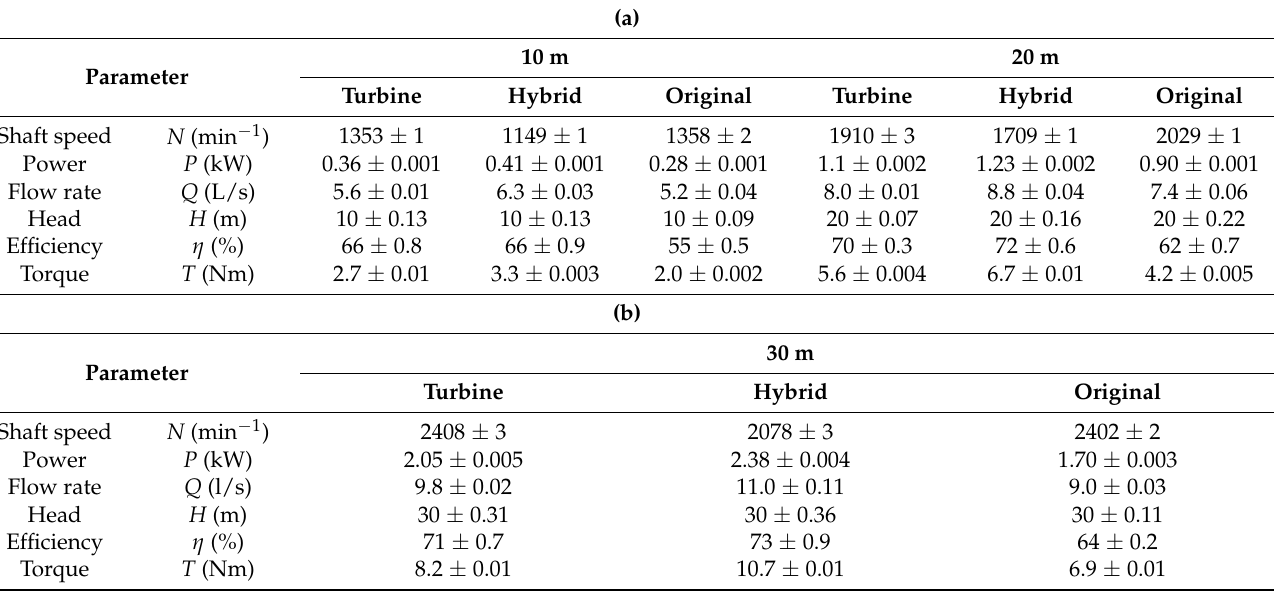
Table 3. ( a ) Overview of absolute values of performance parameters achieved at BEP at net head of 10 and 20 m. ( b ) Overview of absolute values of performance parameters achieved at BEP at net head of 30 m.